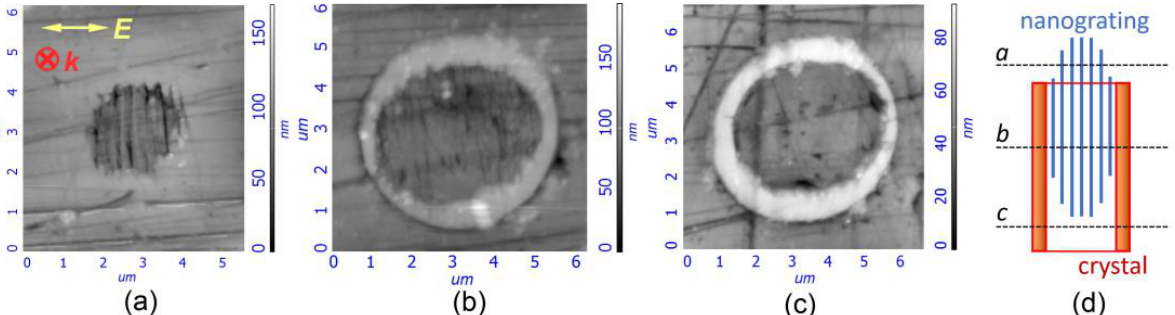
Figure 3. AFM images of the cross-sections of the laser-written birefringent microdomains exposed at a different depth and showing a nanograting ( a ), a nanograting surrounded by crystals ( b ) and a crystalline ring without a nanograting inside it ( c ). A scheme of the cross-section locations relative to the laser-written dot ( d ). The images are acquired from different microdomains written at the same conditions by 10 6 pulses having 210 nJ energy, 1.2 ps duration and 143 kHz PRR. k and E indicate writing laser beam propagation direction and polarization plane orientation, respectively, and are the same for images ( a – c ).